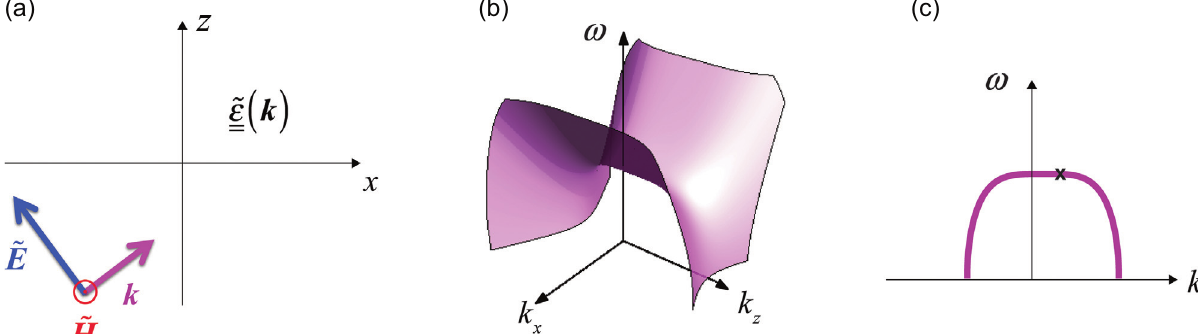
Figure 1. (a) Problem schematic in the assumed 2-D ( x , z ) reference system (with geometry and field quantities independent of y ). We consider a transversely-magnetic-polarized plane-wave (with wavevector k ) propagating in a homogenous space filled up by a nonlocal, nonmagnetic, anisotropic medium characterized by a relative-permittivity constitutive tensor ~ e k ð Þ . (b) Qualitative example of ideal dispersion surface [cf. Eq. (3)] pertaining to the assumed constitutive blueprints [cf. Eqs. (4) and (6), with ~ R ¼ 0]. (c) Corresponding dispersion diagram ( k x = 0 cut), with the black-cross marker indicating the DBE-type stationary